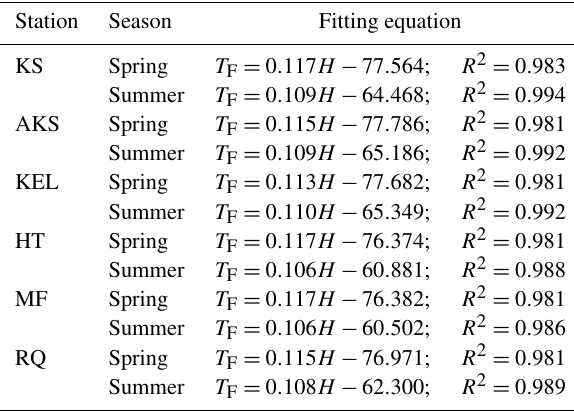
Table 1. Fitting equations for each station based on Eq. (1).